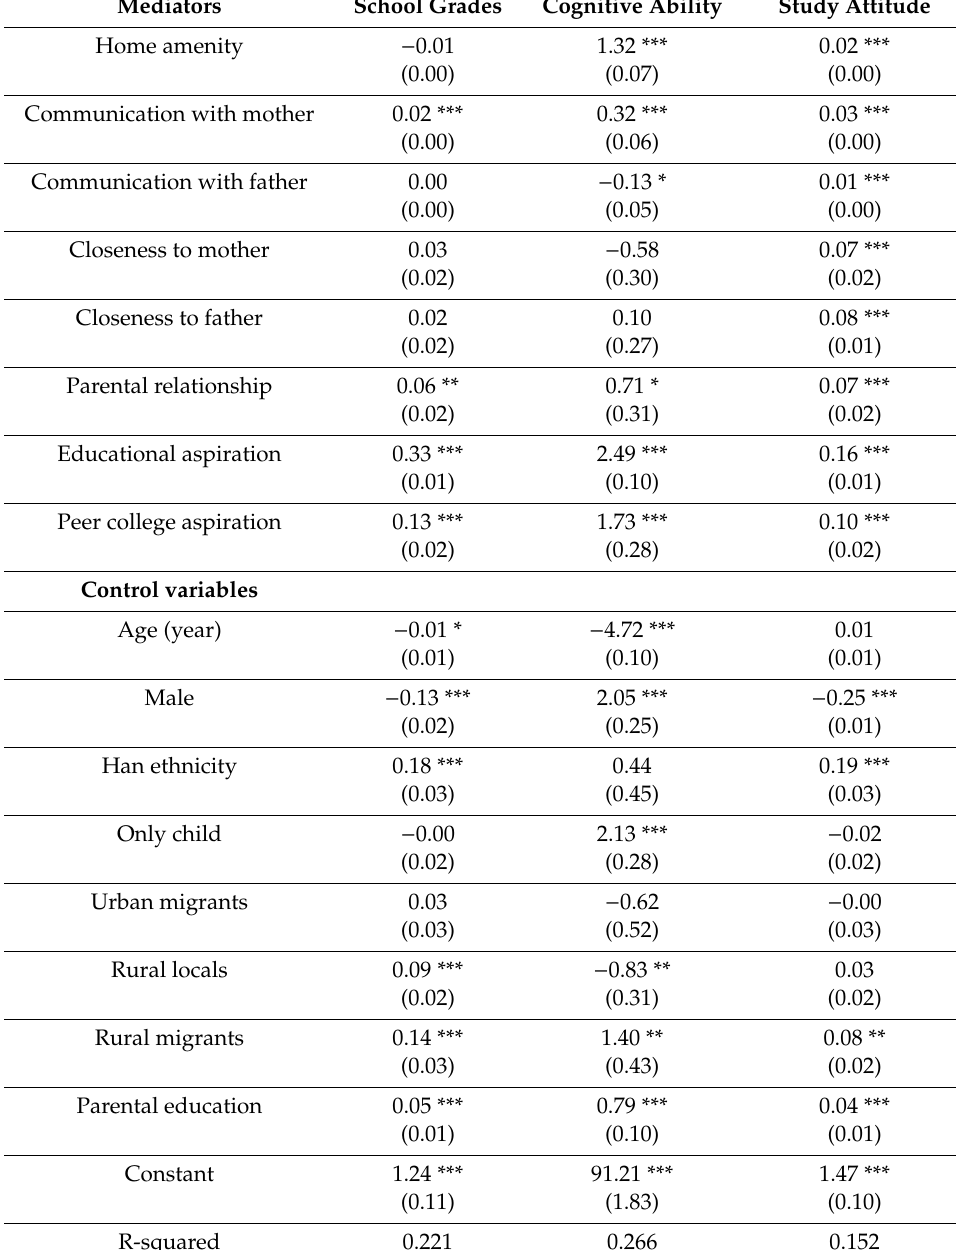
Table 4. The Associations between the Hypothesized Mediators and Cognitive and Educational